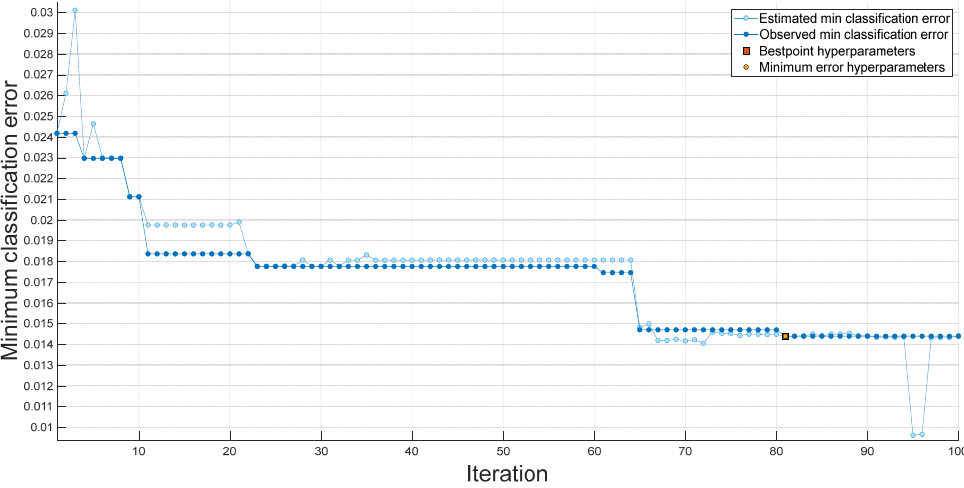
Figure 6. Graph of classification errors versus iterations obtained using SVM for dataset 1.